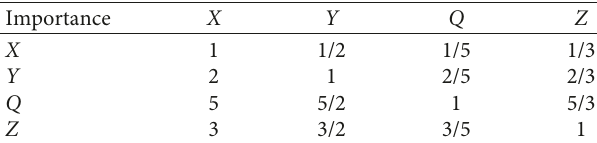
Table 4: Standard comparison judgment